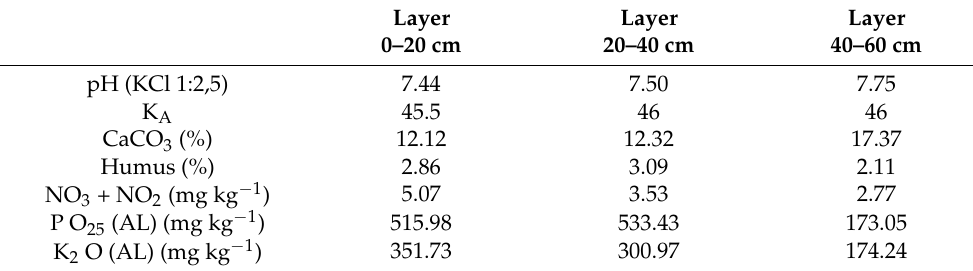
Table 1. Main soil properties of the experimental area (Debrecen-L á t ó k é p,